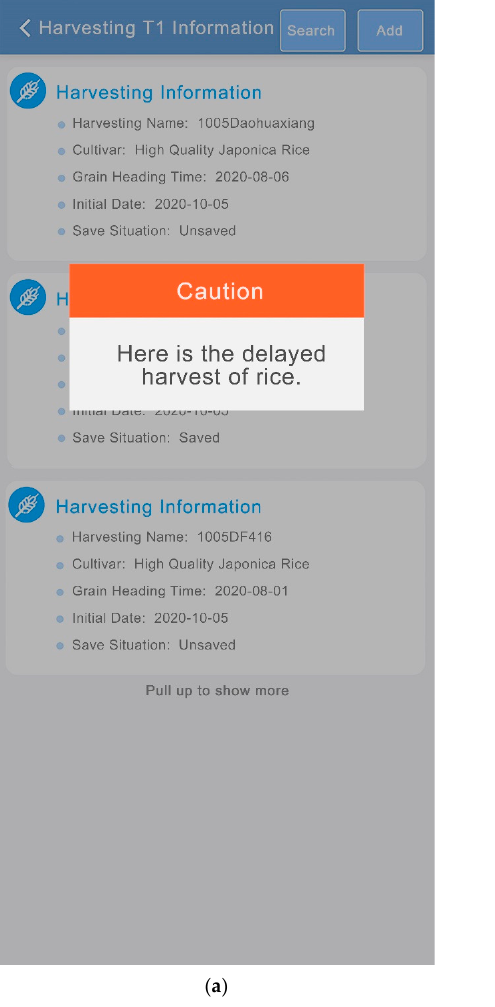
terminal will remind for the delayed operation (if any) according to the har- vesting time offset in the technique code (Figure 13). Targeting the character- istics of large hysteresis, non-linearity, and strong coupling in the post-harvest drying of rice, a multi-hidden layer BP neural network model is established using deep learning techniques. For optimal intelligent control of drying, pre- cise regulation signals for local segmentation are generated and self-opti- Figure 12. Function modules of Agricultural Production Data Management System. Figure 12. Function modules of Agricultural Production Data Management System. mized with the continuous increase of drying data [89]. Further, the decision-maker programs post-harvest operation and agri-